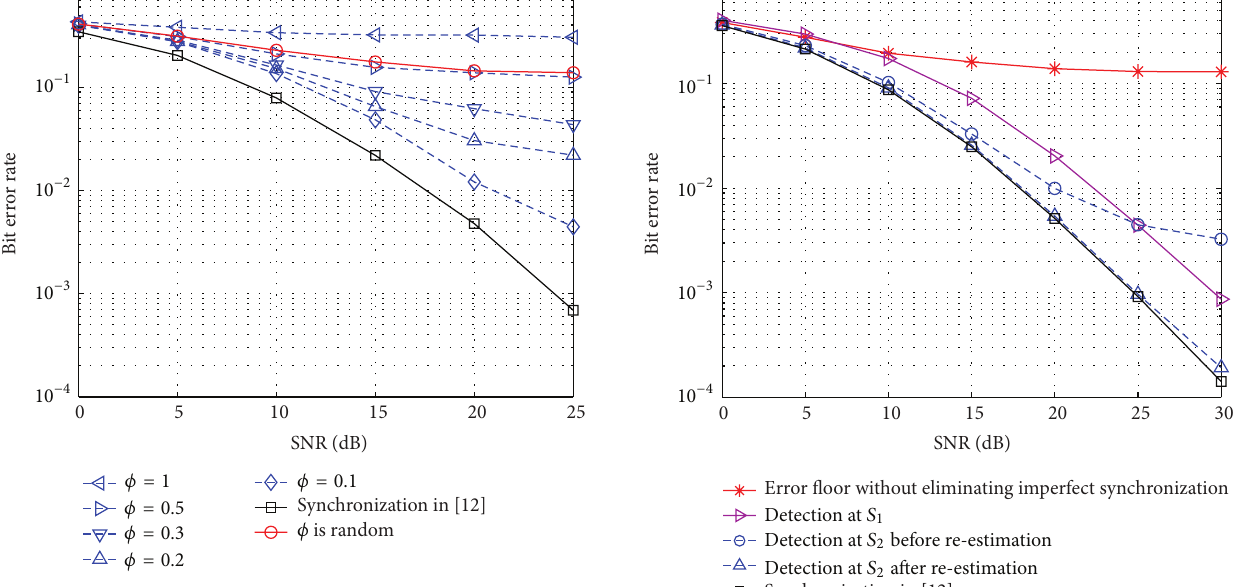
Figure 3: BER performance of detection scheme on nodes 𝑆 1 and 𝑆 2